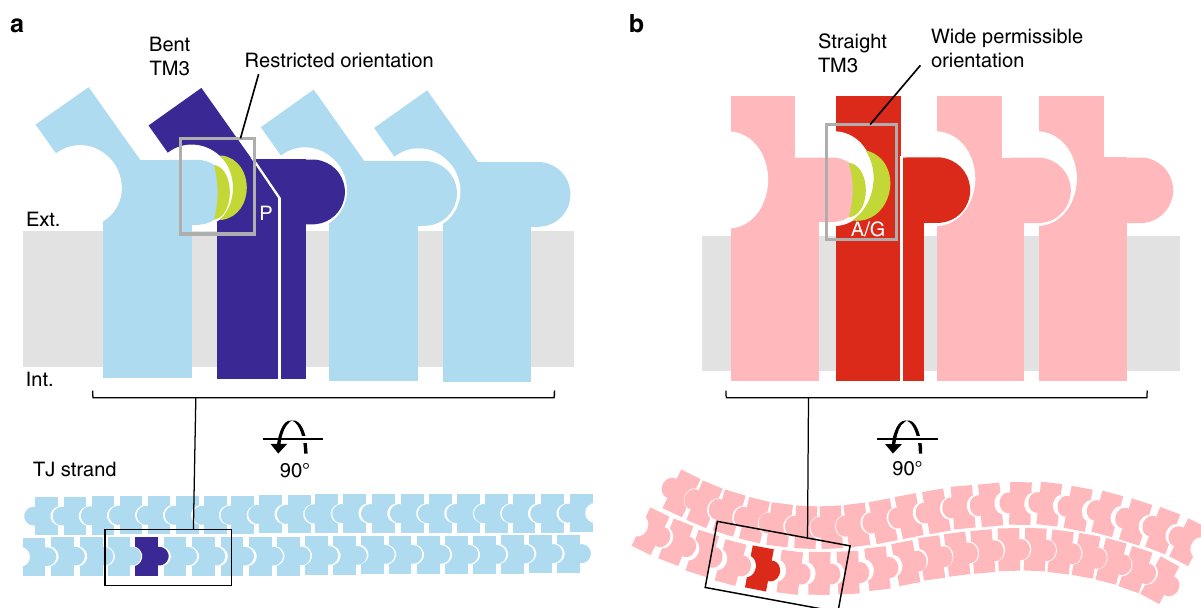
Fig. 6 Mechanism for determining the fl exibility of TJ strands by TM3 bending. a Proline renders TM3 bent, as seen in the mCldn3 cryst structure, with the formation of a narrow cis-interaction pocket. The narrow pocket would restrict the orientation of the cis-interaction, resulting in linear TJ strands having little fl exibility. b The alanine or glycine renders TM3 straight, as seen in mCldn3 cryst P134A or P134G structure, with the formation of a wide cis-interaction pocket. The wide pocket would enable wide orientation range, resulting in curvy TJ strands with high fl exibility. Hydrophobic interactions in cis-interaction are represented in green. TJ strands are depicted according to the anti-parallel double-row